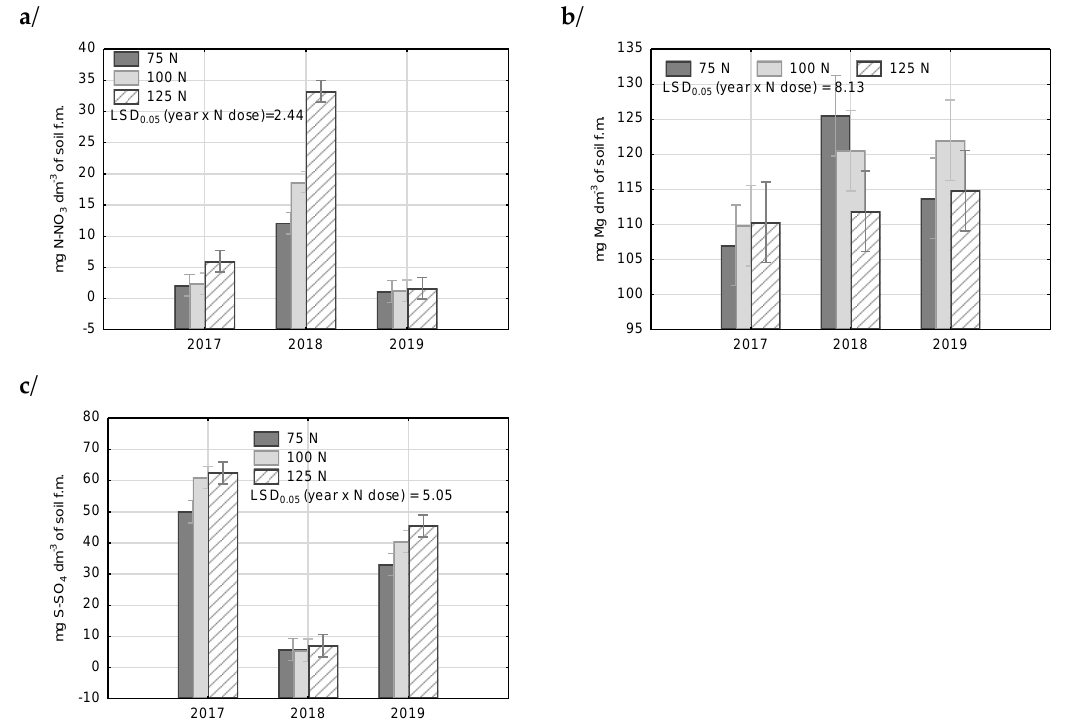
Figure 3. Ammonium, nitrate, and magnesium nitrogen content (mg dm − 3 ) in the soil depending on the applied nitrogen fertilizer dose, in 2017 – 2019 (average of biochar doses).